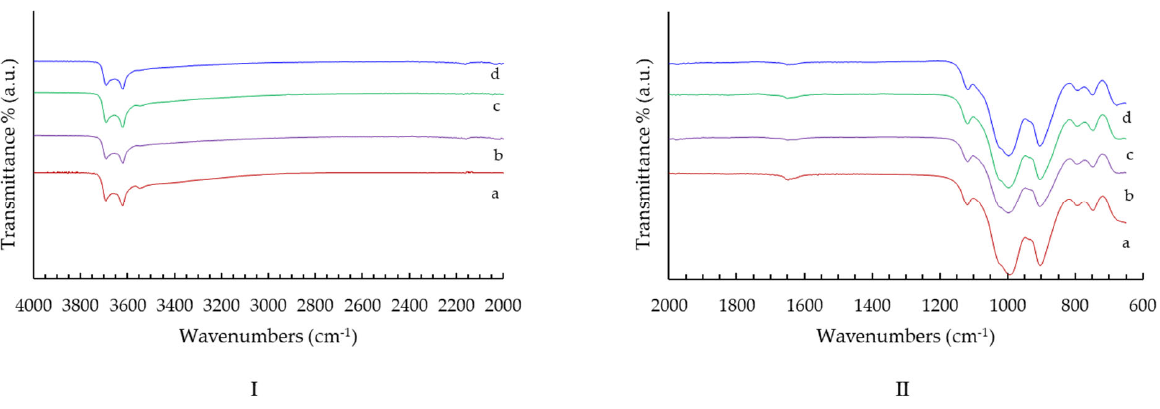
Figure 3. FT-IR spectra of H (a), H_HCl_8M (b), H_H 2 SO 4 _0.5M (c), and H_NaOH_0.5M (d) in 4000–2000 cm − 1 ( I ) and 2000–600 cm − 1 ( II ) wavenumber